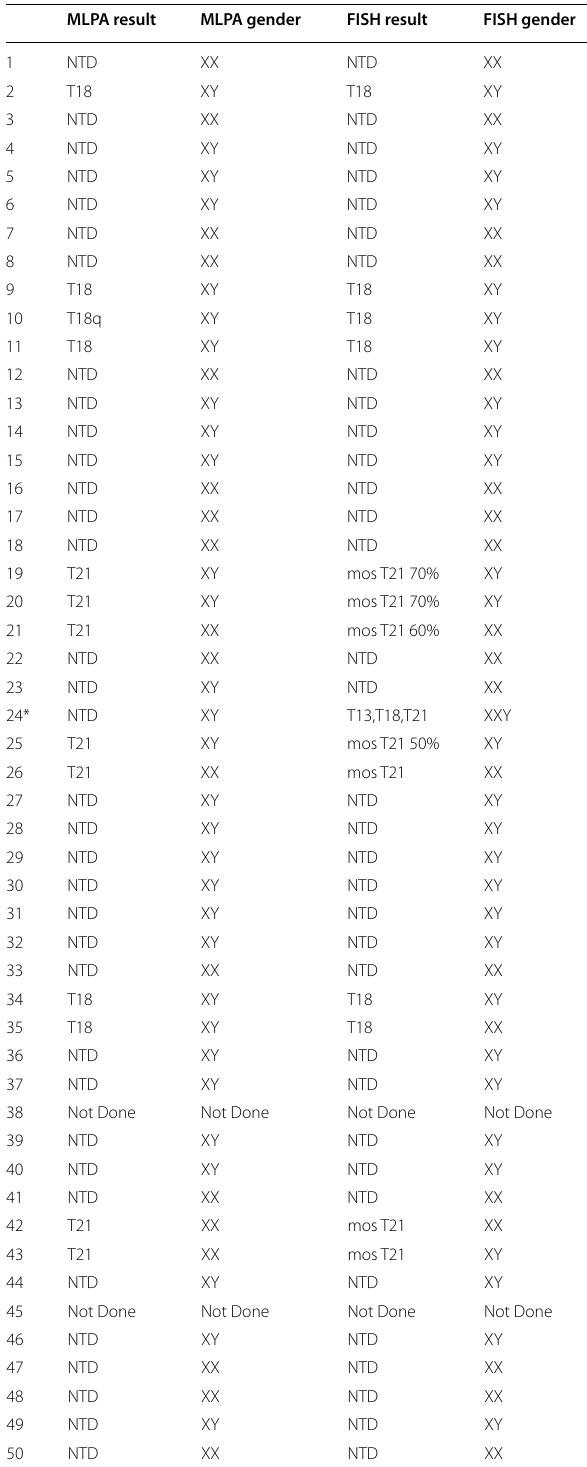
NTD no trisomy detected. *T2 was detected in this sample and with the other trisomies, indicating triploidy